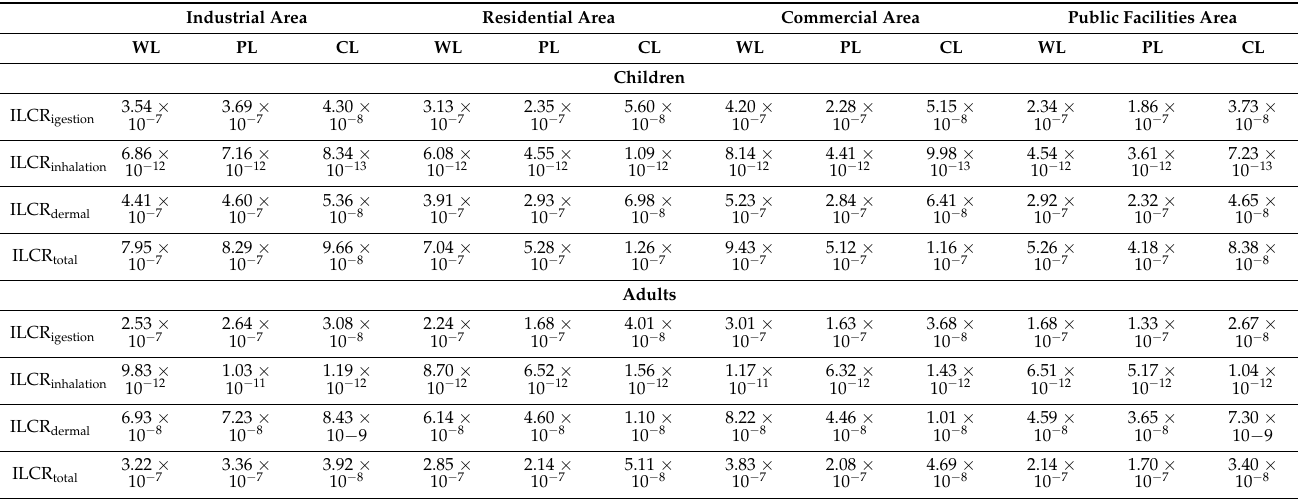
Table 4. Values of ILCRs of PAHs in different land use categories of street dust during partial and complete lockdowns and after the lockdown.